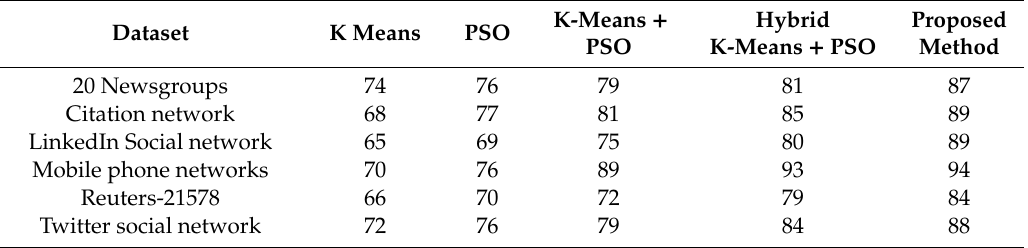
Table 7. Clustering and analyzing comparison.